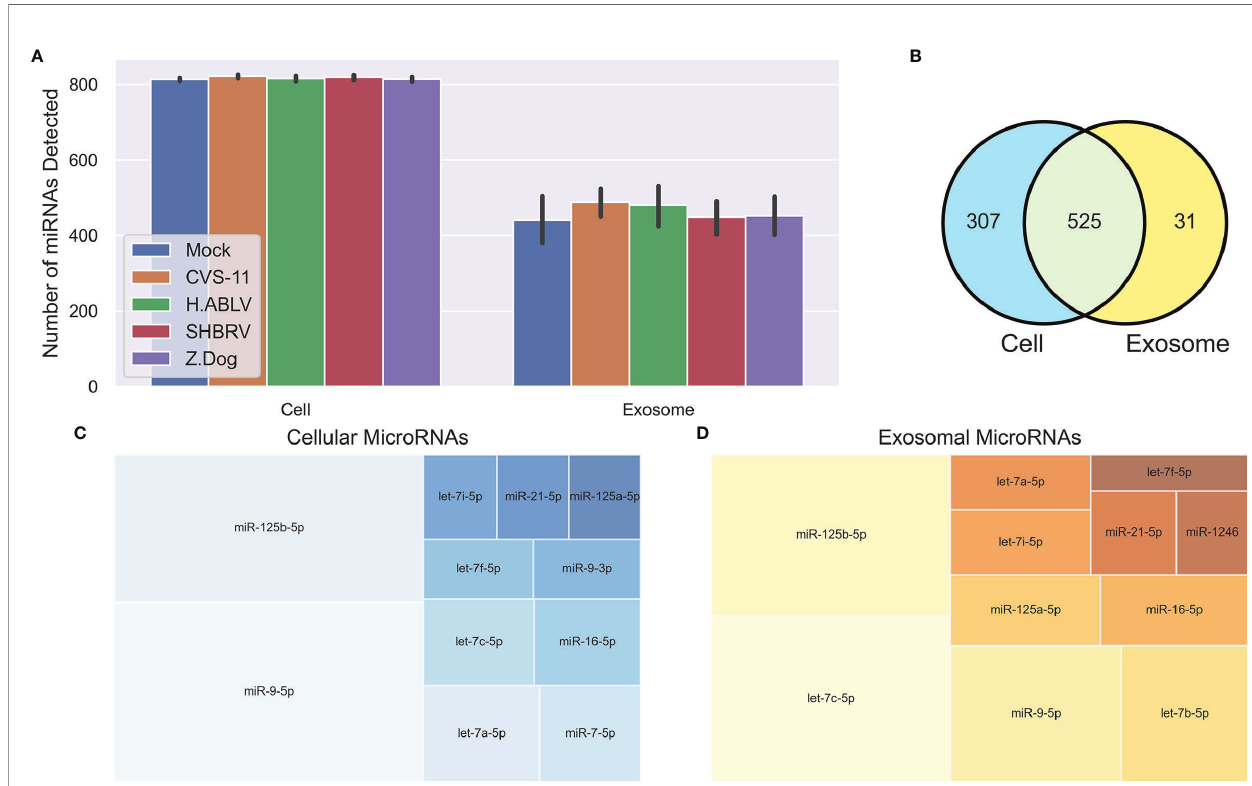
FIGURE 2 | Overview of neuronal cellular and exosomal miRNAs. (A) Barplot of the number of mature miRNAs detected in cells or exosomes from each condition – Mock infection (blue, n = 6 cell, 9 exosome), CVS-11 (orange, n = 8 cell, 9 exosome), H.ABLV (green, n = 5 cell, 9 exosome), SHBRV (red, n = 5 cell, 9 exosome), and Z.Dog (purple, n = 6 cell, 9 exosome). All sample numbers are technical replicates obtained from three separate biological experiments. Error bars are 95% CI. (B) Venn diagram of the mature miRNAs detected in the neural cultures, exosomes or both. (C, D) Treemap plots displaying the most abundant miRNAs (each miRNA has > 2% of the total reads) in the neural (C) cells and (D)